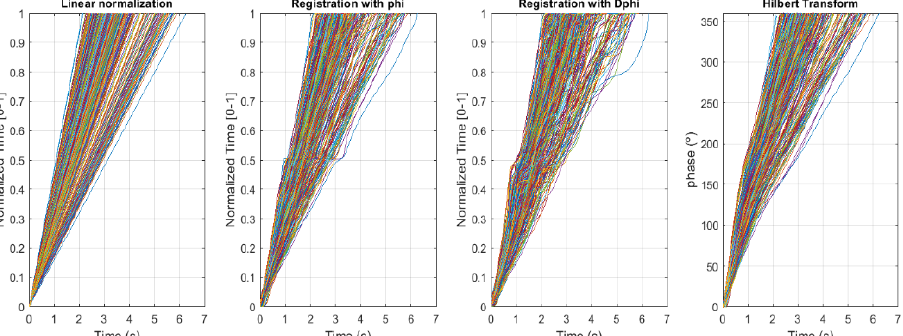
Figure 5. Normalized acceleration (D2phi) curves for the four methods compared, together with their functional means (solid black line) and functional standard deviations (dashed black line).